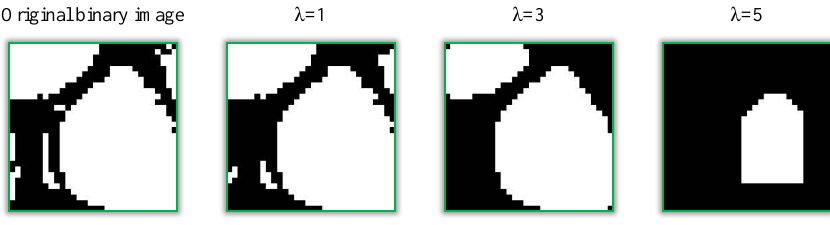
Figure 5. Graphical demonstration for corroding operation based on different values of λ after five iterative